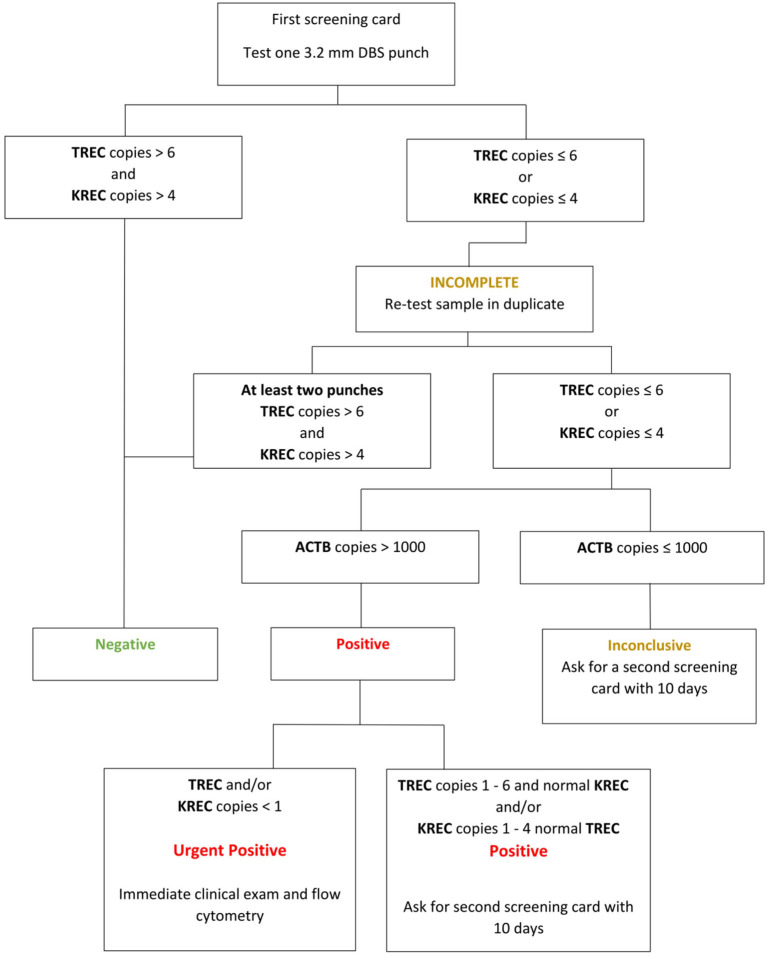
Interpretation of the SCID NBS results (TREC and KREC copies) according to ImmunoIVD.